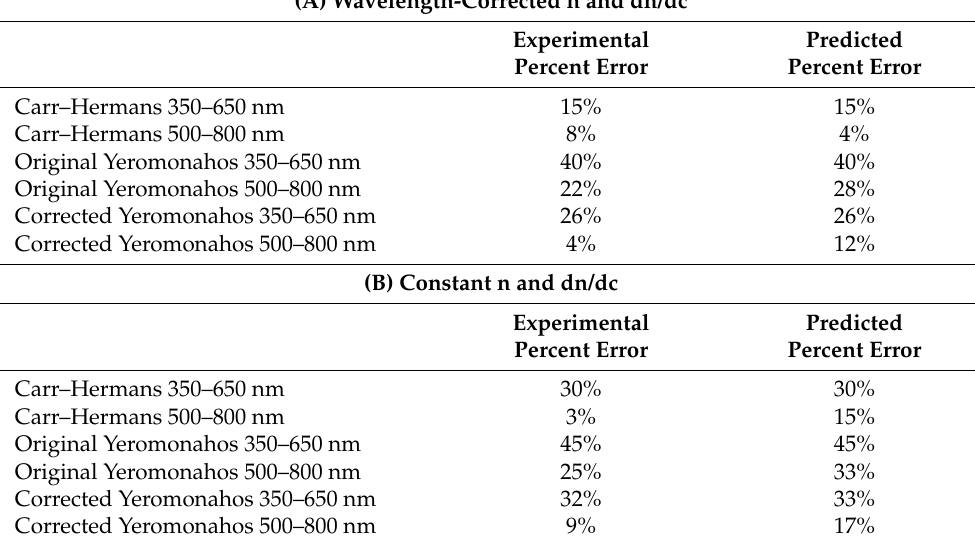
Table 4. The percent error in the diameter values obtained experimentally using the turbidimetric fitting approaches (middle column), and the percent error predicted by the numerical simulations (right column), with (A) the wavelength dependence of n and dn/dc accounted for, and (B) using constant values of n and dn/dc. Clot formed from 0.5 mg/mL fibrinogen and 0.1 NIH-U/mL thrombin in HBS buffer + 5 mM calcium